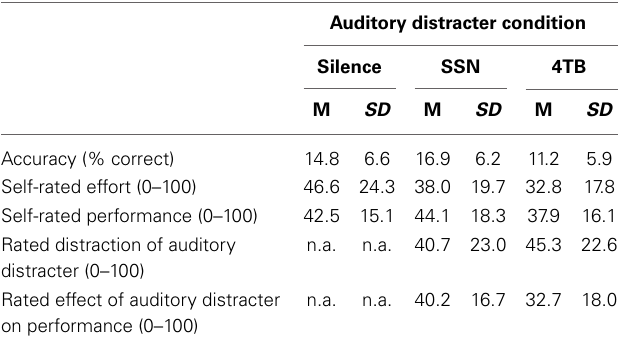
accuracy, and self-ratings of effort, performance, distraction, and effect of auditory distracter on